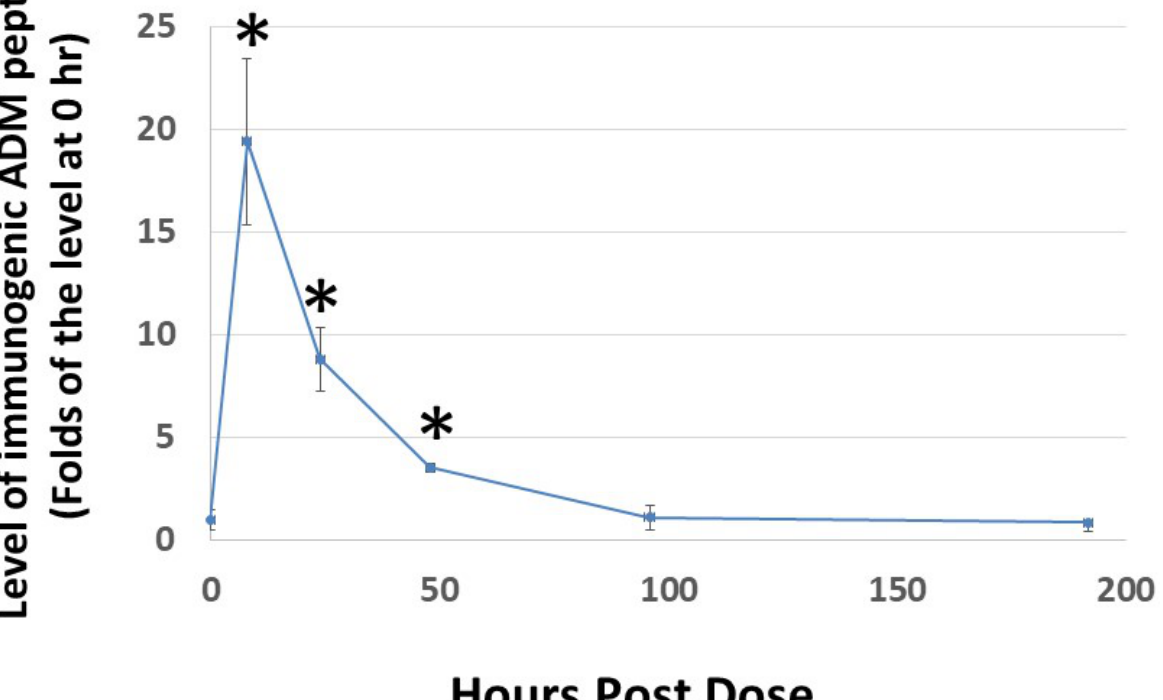
Figure 6. Subcutaneous administration of Analog C-6 gel solution leads to the sustained presence of the peptide in the circulation of rats. The circulating level of Analog C-6 was significantly increased in the circulation from 8 to 48 h after injection. An aliquot of Analog C-6 gel solution (32 mg in 16% solution) was delivered subcutaneously in male adult Sprague–Dawley rats, and blood samples were collected at pre-dose, 8, 24, 48, 96, and 192 h after injection. The peptide level was determined by specific ADM EIA. *, Significantly different from controls at 0 h. Data are mean ± SEM of three separate animals.